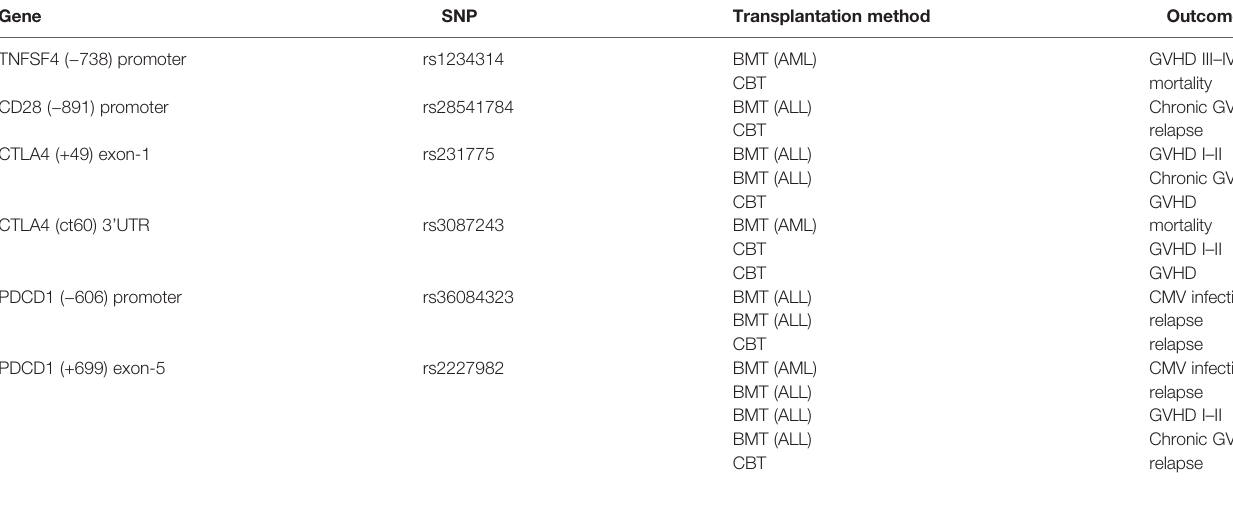
TABLE 7 | Summarized the SNPs that were associated with adverse outcomes of post-BMT and post-CBT.